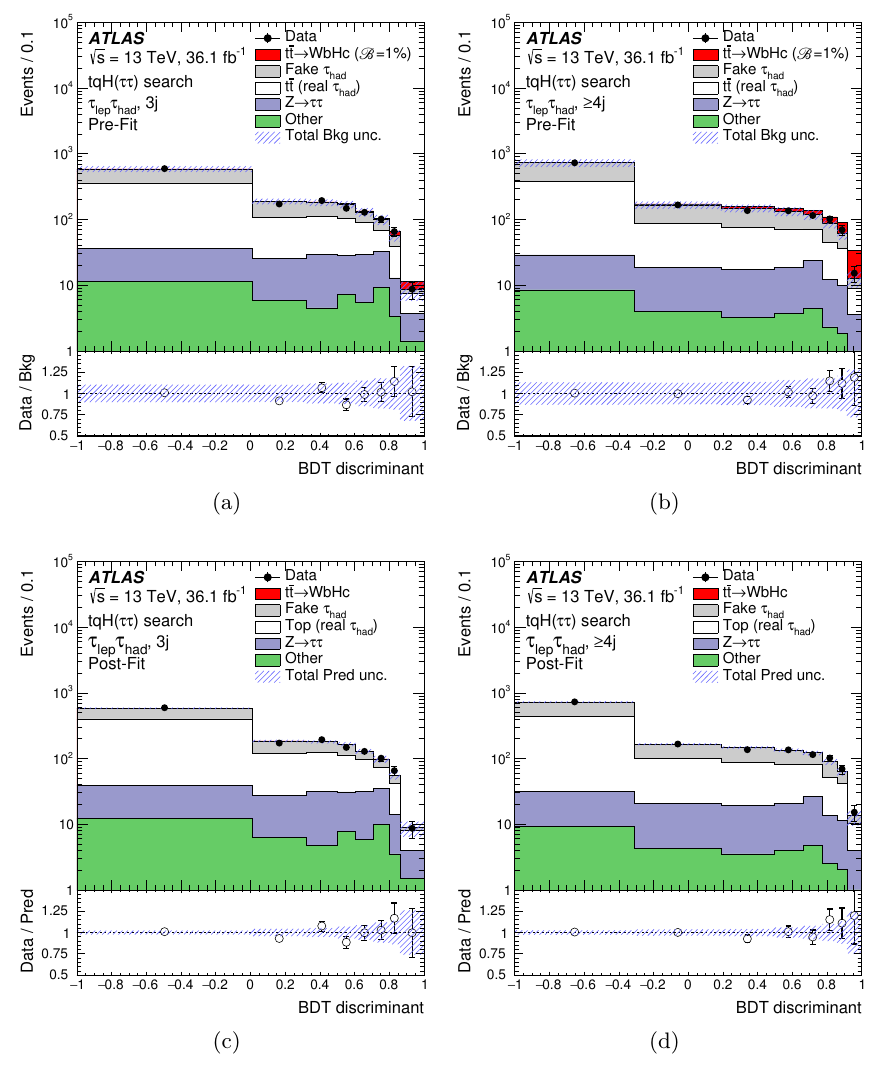
Figure 9 . tqH ( (cid:28)(cid:28) ) search: comparison between the data and prediction for the BDT discriminant distribution in the (cid:28) lep (cid:28) had channel, before and after the (cid:12)t to data (\Pre-Fit" and \Post-Fit", respectively) under the signal-plus-background hypothesis. Shown are the ( (cid:28) lep (cid:28) had , 3j) region (a) pre-(cid:12)t and (c) post-(cid:12)t, and the ( (cid:28) lep (cid:28) had , (cid:21) 4j) region (b) pre-(cid:12)t and (d) post-(cid:12)t. The contributions with real (cid:28) had candidates from t (cid:22) t , t (cid:22) tV , t (cid:22) tH , and single-top-quark backgrounds are combined into a single background source referred to as \Top (real (cid:28) had )", whereas the small contributions from Z ! ‘ + ‘ (cid:0) ( ‘ = e; (cid:22) ) and diboson backgrounds are combined into \Other". In the pre-(cid:12)t (cid:12)gures the expected t (cid:22) t ! WbHc signal (solid red) corresponding to B ( t ! Hc ) = 1% is also shown, added to the background prediction. In the post-(cid:12)t (cid:12)gures, the t (cid:22) t ! WbHc signal is normalised using the best-(cid:12)t branching ratio, B ( t ! Hc ) = ( (cid:0) 4 : 4 +9 : 9 ) (cid:2) 10 (cid:0) 4 . The bottom panels display the (cid:0) 8 : 5 ratios of data to either the SM background prediction before the (cid:12)t (\Bkg") or the total signal- plus-background prediction after the (cid:12)t (\Pred"). The hashed area represents the total uncertainty of the background. In the case of the pre-(cid:12)t background uncertainty, the normalisation uncertainty of the fake (cid:28) had background is not included.